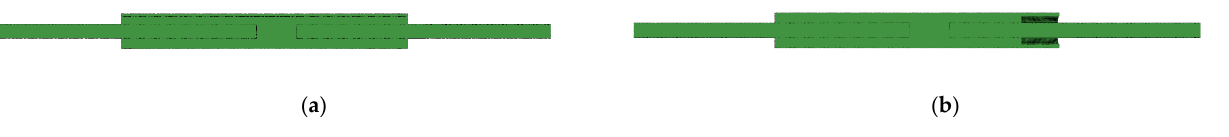
Figure 8. Grouting defect grid schematics. ( a ) Without defects. ( b ) With 25% defects at the end.